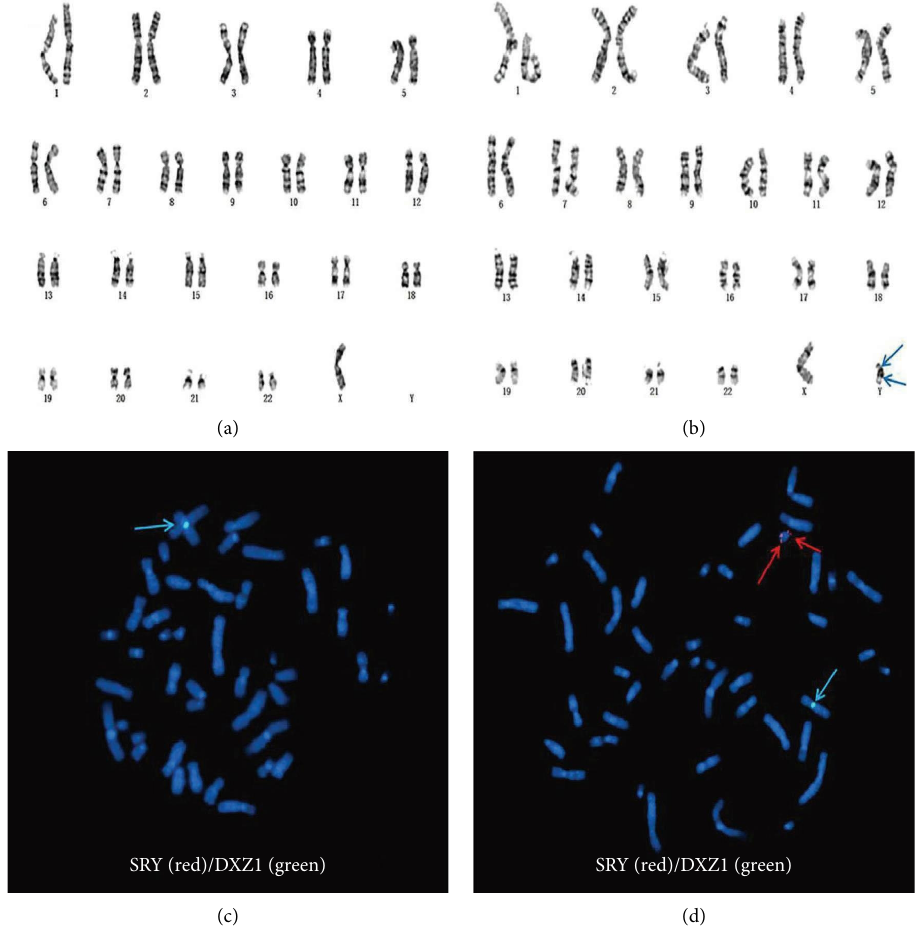
Figure 1: G-banding karyotype (a, b) combined with FISH (c, d) of the young girl’s peripheral blood: mos 45, X [3]/46, X, ish psu idic (Y) (q11.2) (DXZ1+) (SRY++) [37]; (b) blue arrows indicated two centromere regions. (c, d): green arrows indicated X chromosome cen- tromeric signals, and red arrows showed two SRY-specifc signals on the two distal tips of the long arm of chromosome Y.